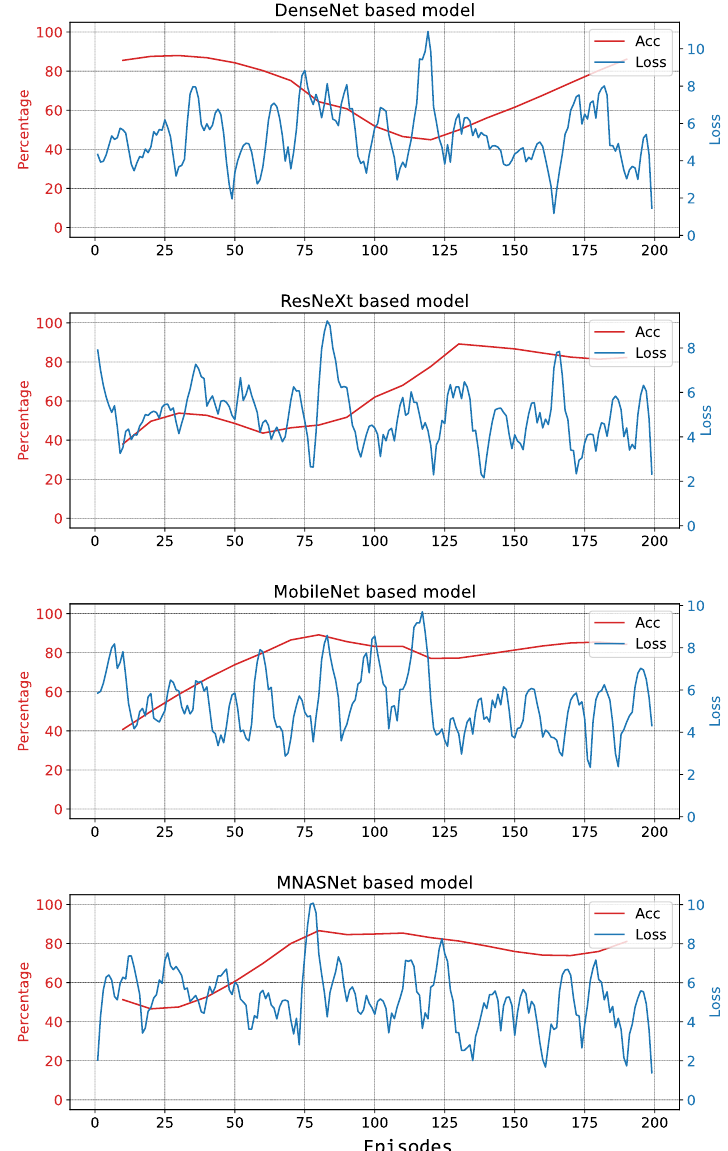
Figure 9. Evolution of loss (blue) and accuracy (red) of the system during 200 episodes of the first testing session on a real robot. Data was smoothed using a third order